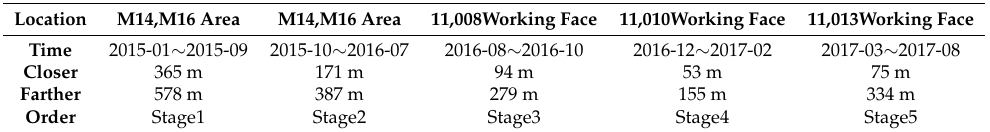
Table 1. Mining location and schedule.